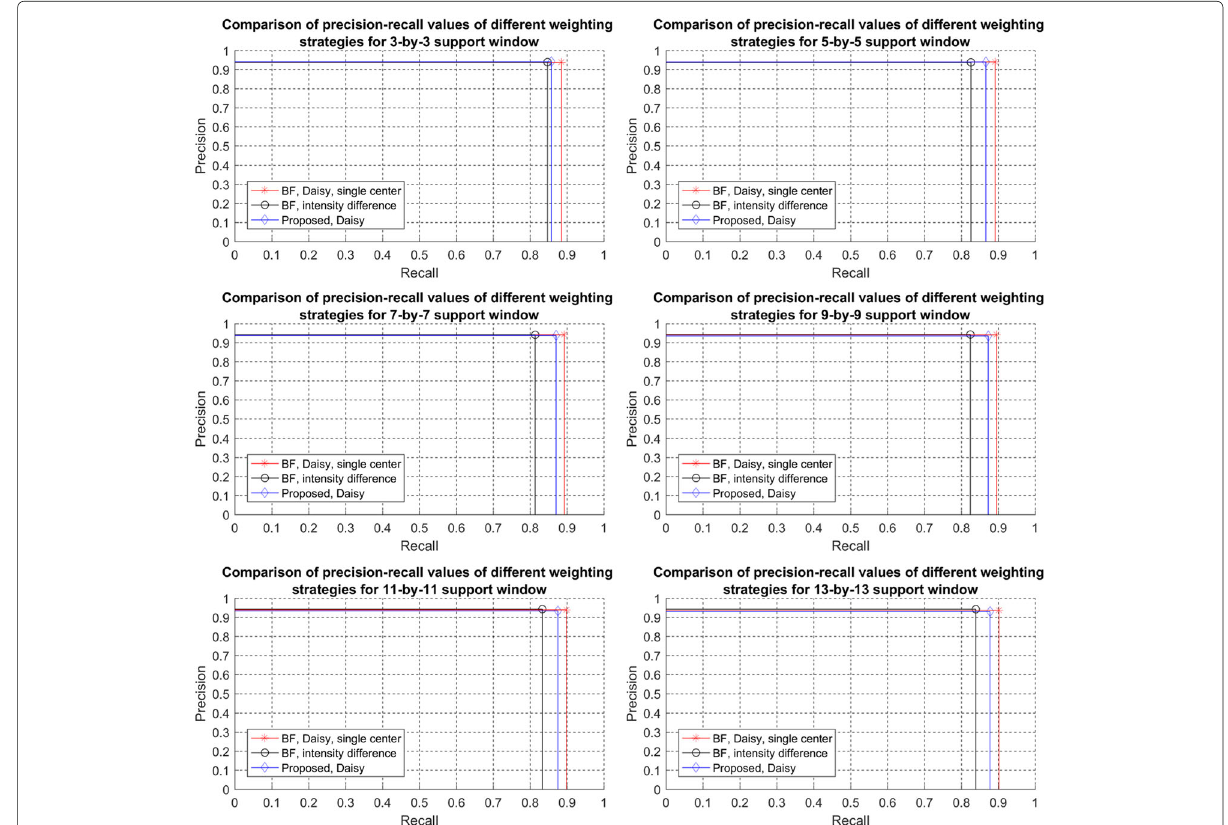
Fig. 6 Performance comparison of the proposed and two other bilateral-filtering-based weighing strategies on the stereo pair in Fig.